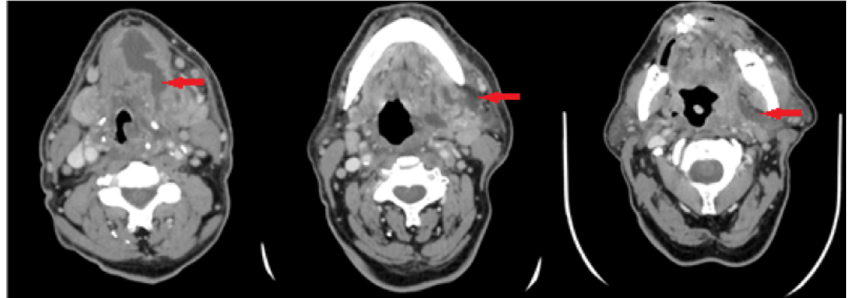
Fig. 6. Cervicofacial CT scan with evidence of